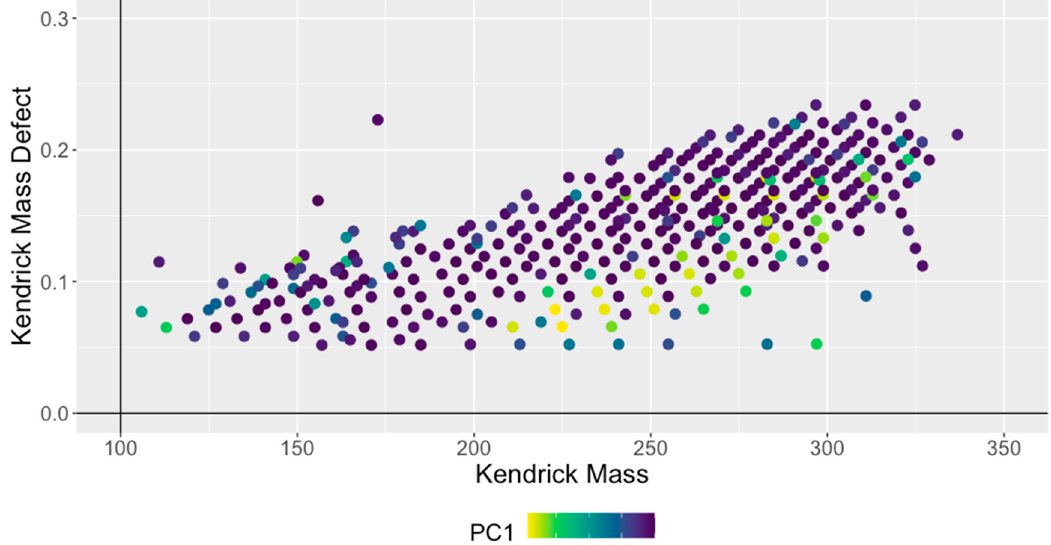
Figure 2. A Kendrick plot of all formulae used to calculate sample distribution in the previous PCA (Figure 1). Formulae are colour-coded according to factor loadings according to principal component one (PC1).